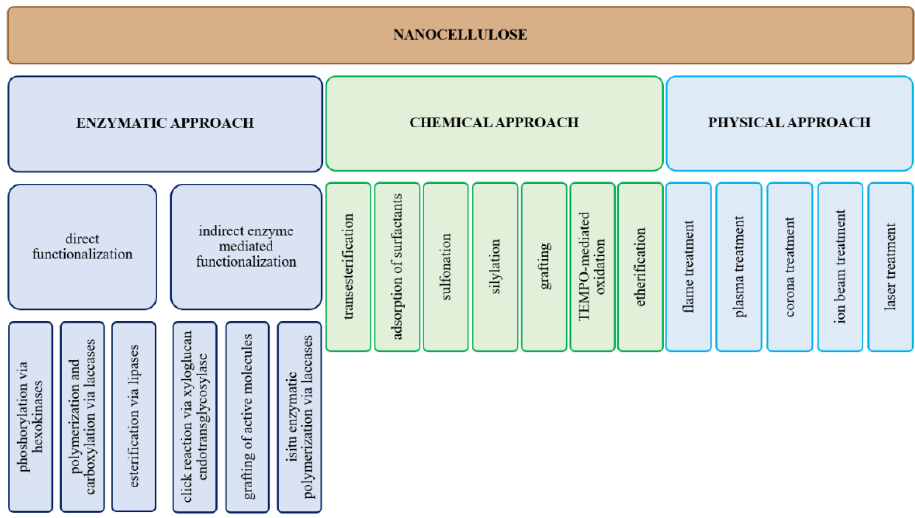
Figure 3. Approaches to surface modification of nanocellulose. 7. Modification Methods of Cement Composites with Nanocellulose and Surface Modified Nanocellulose and Effect of Nanocellulose Types on Physical, Chemical